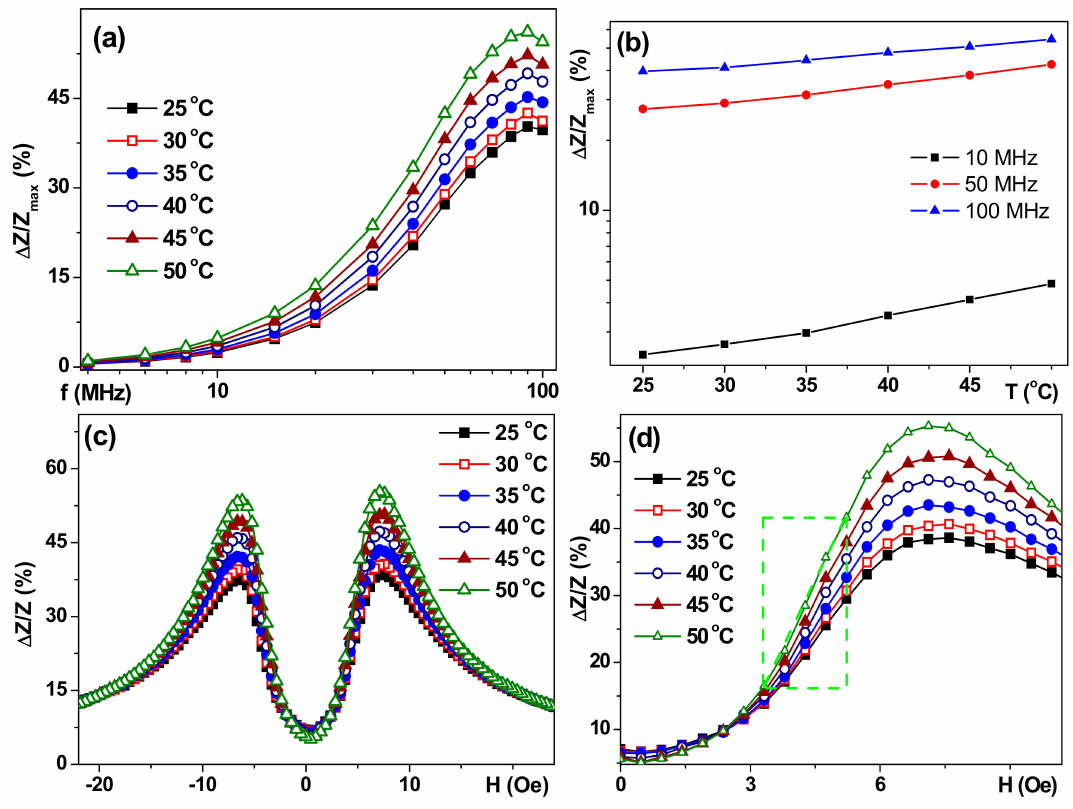
Figure 4. S-type multilayered structure. Frequency dependencies of the ∆ Z/Z max GMI ratios for selected temperatures ( a ). Temperature dependencies of the ∆ Z/Z max GMI ratio for selected frequencies ( b ). Field dependencies of the GMI ratio at f = 80 MHz ( c , d ) at different temperatures. A section of linear dependence of a ∆ Z/Z (working interval) is shown by the light green dashed line ( d ). Only one branch of the GMI curve after saturation in the high positive field is shown for ( c , d )